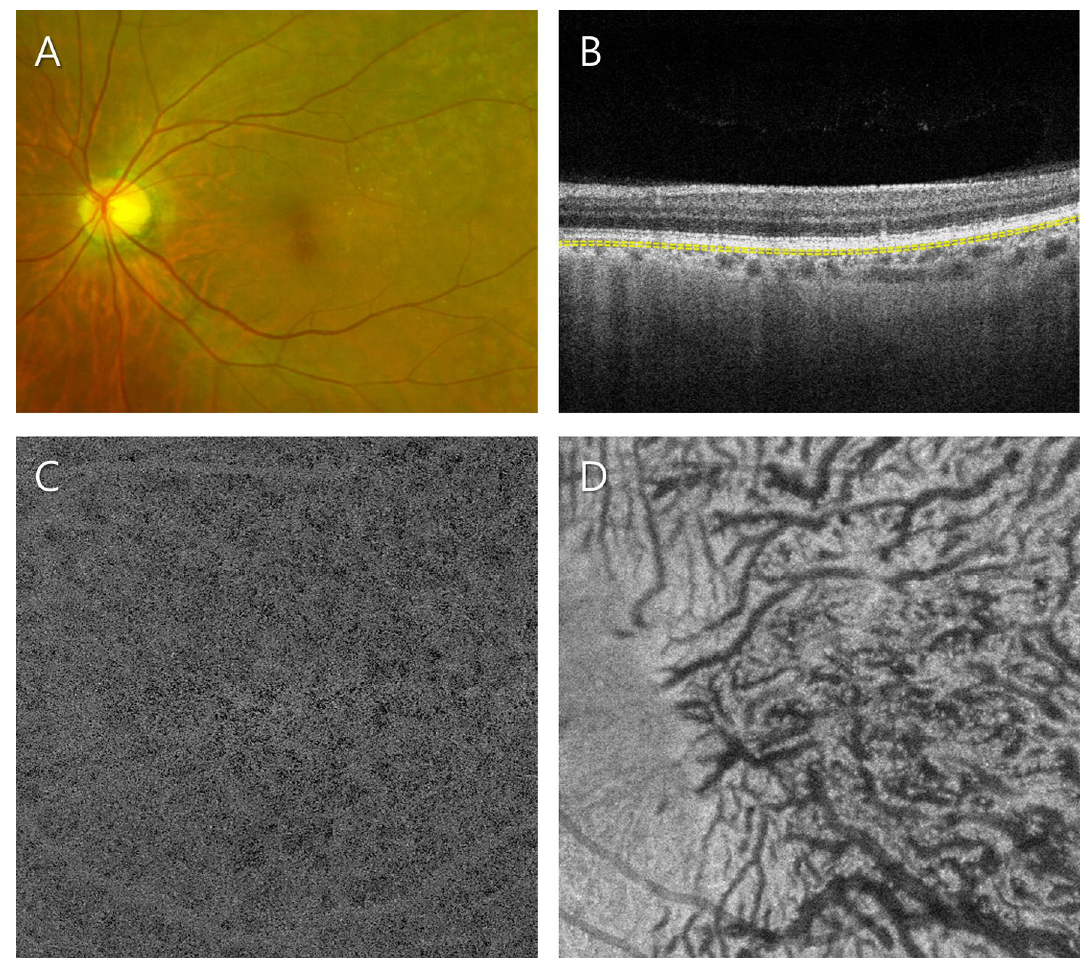
Figure 5. Representative patient in the subretinal drusenoid deposit (SDD)-only group. ( A ) Ultra-widefield fundus photograph showing the dispersed SDD at the superotemporal side. ( B ) Optical coherence tomography (OCT) B-scan image. The subfoveal choroidal thickness was 221 µm. Slab to acquire the choriocapillaris (CC) layer is depicted as a yellow dashed line. ( C ) OCT angiography (OCTA) image of the CC. Enlarged flow voids were notable in all subgroups. The average size, number and total area of flow voids were 317.9 µm 2 , 24,256, and 7.7 mm 2 , respectively. ( D ) Structural en face OCT image of the Haller layer. The mean and standard deviation of the Haller vessel diameter were 84.7 and 36.7 µm, respectively.